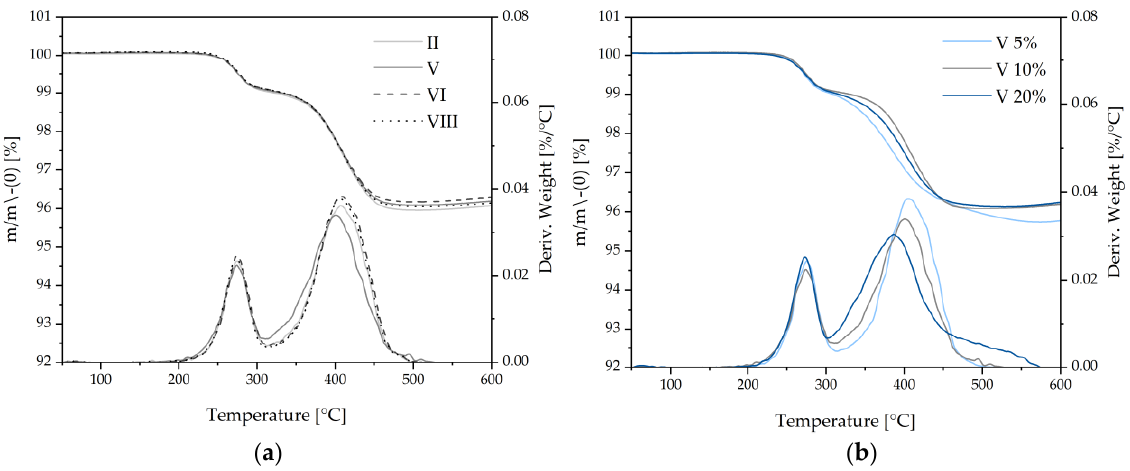
Figure 8. TGA investigations of silicon – graphite anodes ( a ) dried under four different procedures with 10 w solid -% Si content and ( b ) dried under similar laser procedures with 5, 10 and 20 w solid -% Si content.